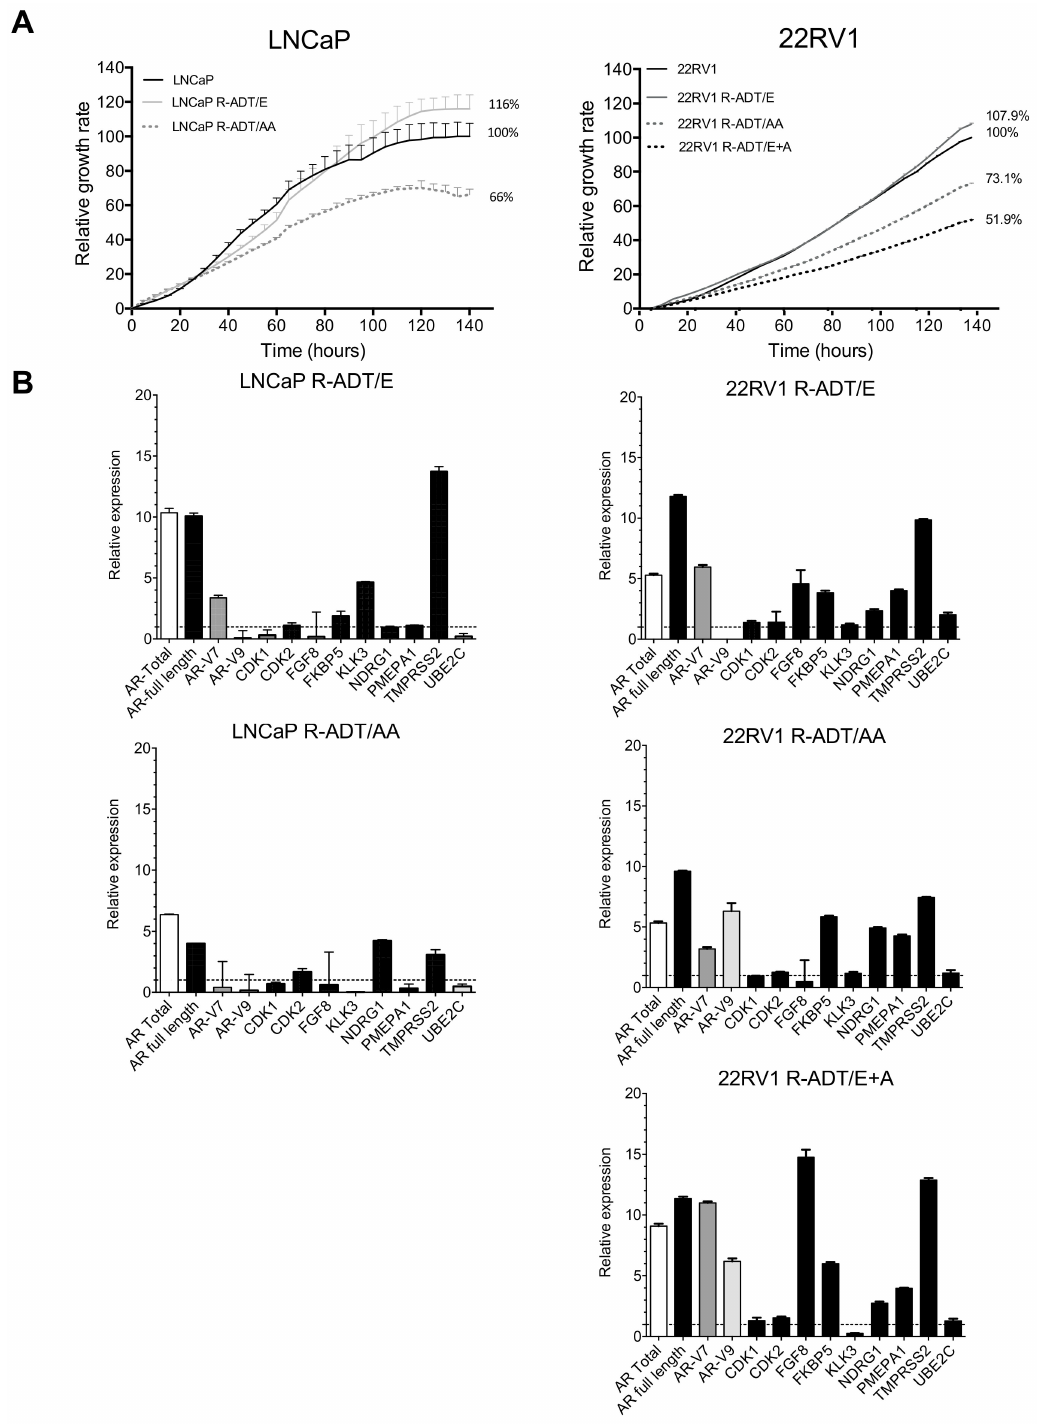
Figure 5. Characterization of NHA-resistant cell lines (R-ADT/E, R-ADT/AA and R-ADT/E + A) by the concomitant use of treatments. LNCaP and 22RV1 wild-type cells were cultured with serum without hormones (CSS) and 40 µ M Enz (R-ADT/E); 20 µ M of AA (R-ADT/AA) and 40 µ M of Enz + 20 µ M of AA (R-ADT/E + AA) for 6 months. ( A ) Cell proliferation analysis using xCELLigence in LNCaP (left panel) and 22RV1 (right panel) cell lines. Results have been standardized considering the final value after 5 days of control cultures to 100%. Data shown correspond to the mean ± SD calculated from the quadruplicates made for each condition. ( B ) qPCR analysis for AR isoforms and AR target genes after in LNCaP (left panels) and 22RV1 (right panels) concomitant cellular models. The results are shown normalized with respect to endogenous control (GADPH) and referenced to the wild-type cell lines. The error bars shown correspond to the SD calculated from